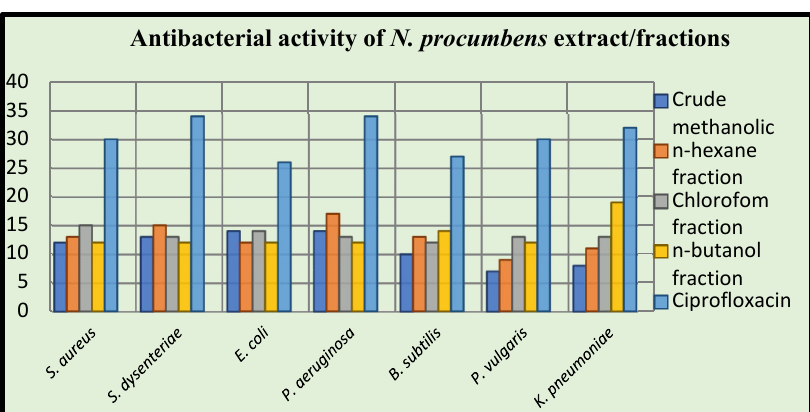
Figure 3. Graphical representation of antibacterial activity of Neurada procumbens.